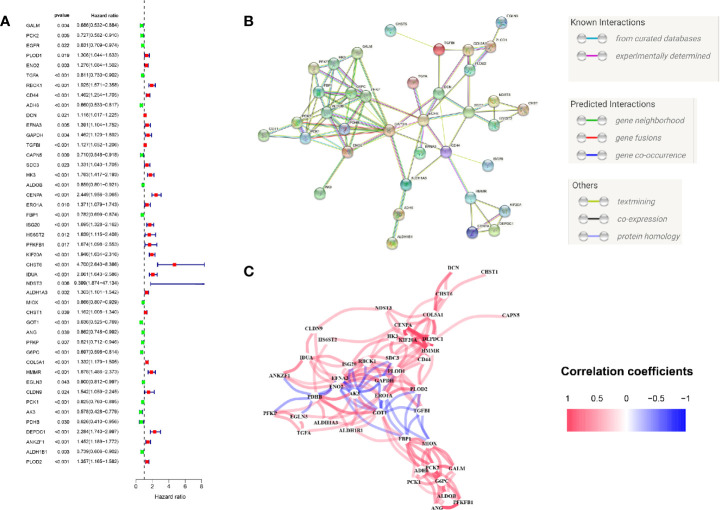
Initial screening of OS-related glycolysis-related genes. (A) 45 genes associated with OS of ccRCC patients were obtained through univariate Cox regression analysis. (B) The Construction of PPI network by STRING. (C) The genes expression correlation network.